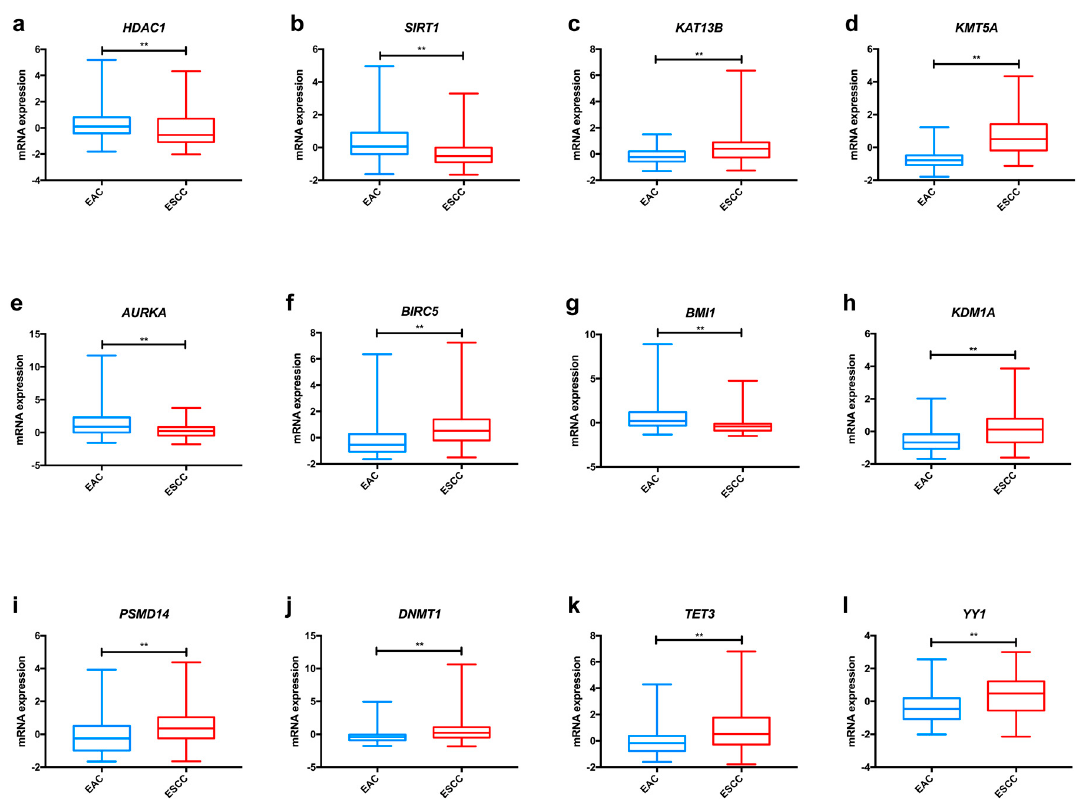
Figure 2. Examples of relevant modifications in the expression of enzymes involved in epigenetic alterations in oesophageal cancer, based on TCGA data analysed through the cBioPortal for